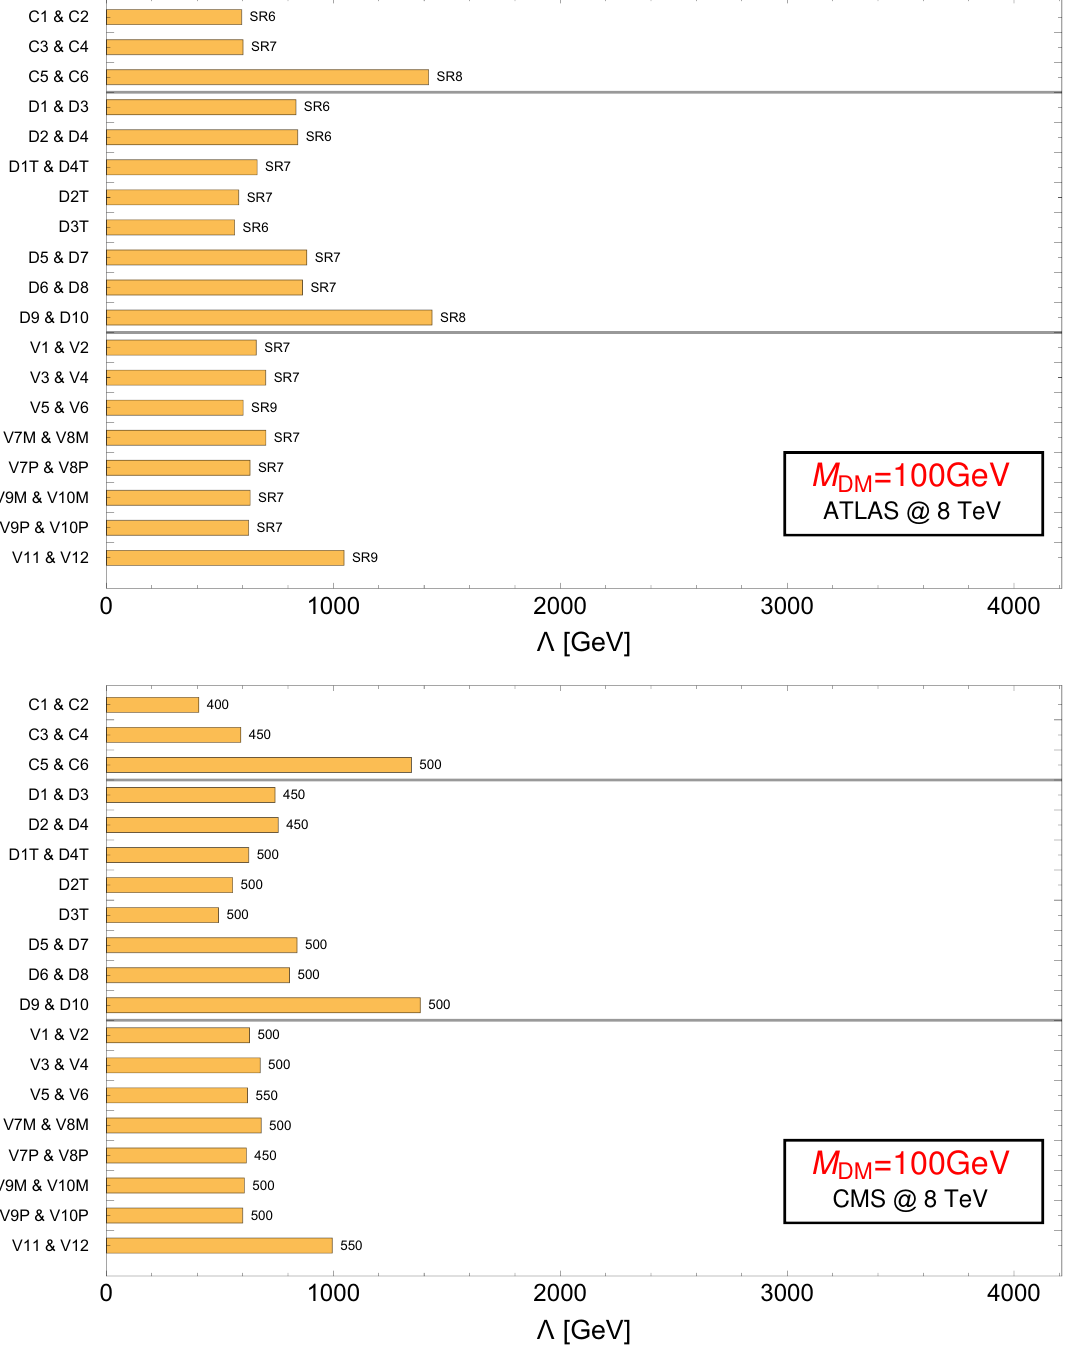
Figure 9 . Observed 95% CL limits on the UV cut-o(cid:11) (cid:3) from LHC 8 TeV data: from the ATLAS search(top) of ref. [1] and from the CMS search (bottom) of ref. [2]. The signal regions which determine the strongest constraint are displayed for each operator. Black horizontal lines distinguish groups of operators for same-spin DM.